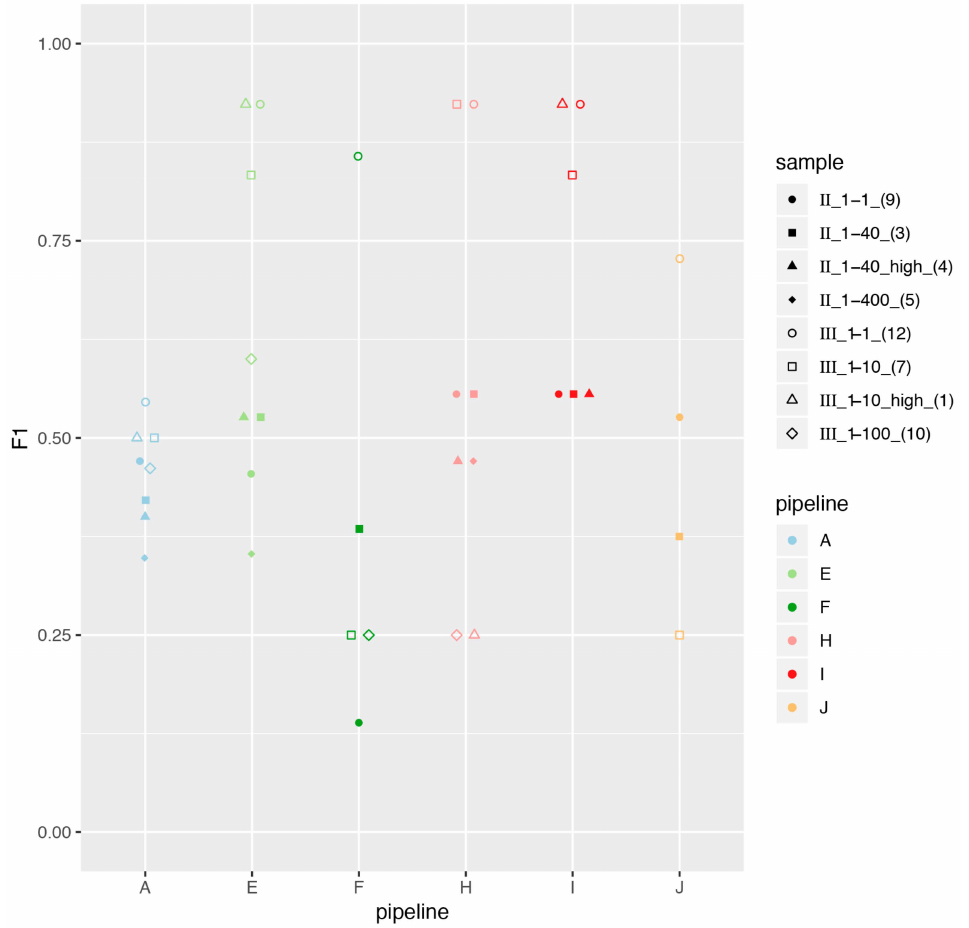
Figure 4. Performance across pipelines for increment 2 in-silico-generated datasets. We report the F1-score obtained by each pipeline on the artificial datasets, using the SIB-provided database. Note that participants sometimes reported no viruses at all in some of the artificial samples, and we could therefore not calculate an F1-score for these samples (missing markers in the plot). In addition, as pipeline I had identified viruses in various settings (1 × 100 bp, 1 × 150 bp, 1 × 250 bp), we display here the results obtained only with 1 × 150 bp, which correspond to the sequencing settings they used in increment 1. Note that data points were jittered horizontally for